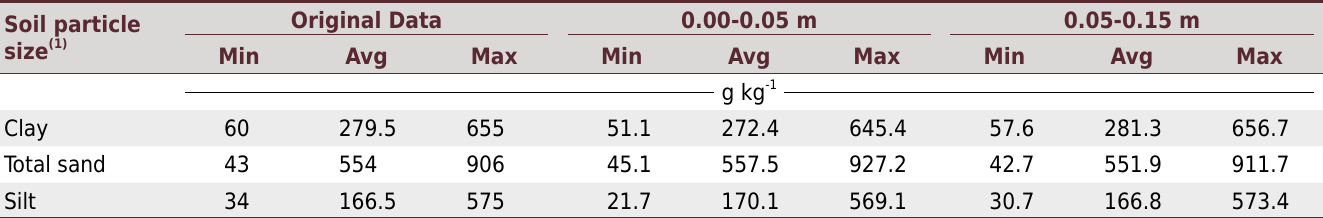
Min = minimum; Avg = average; Max = maximum. (1) Obtained by densimeter method (Donagema et al., 2011), classified as clay (<0.002 mm), silt (0.002-0.05 mm), and sand (>0.05